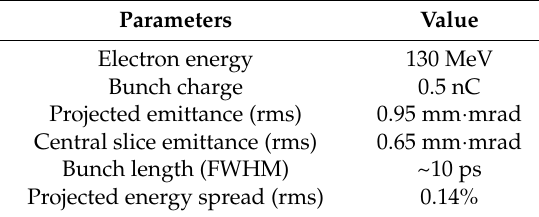
Table 2. Main electron beam parameters of the SXFEL injector. (Reprint from reference [26])